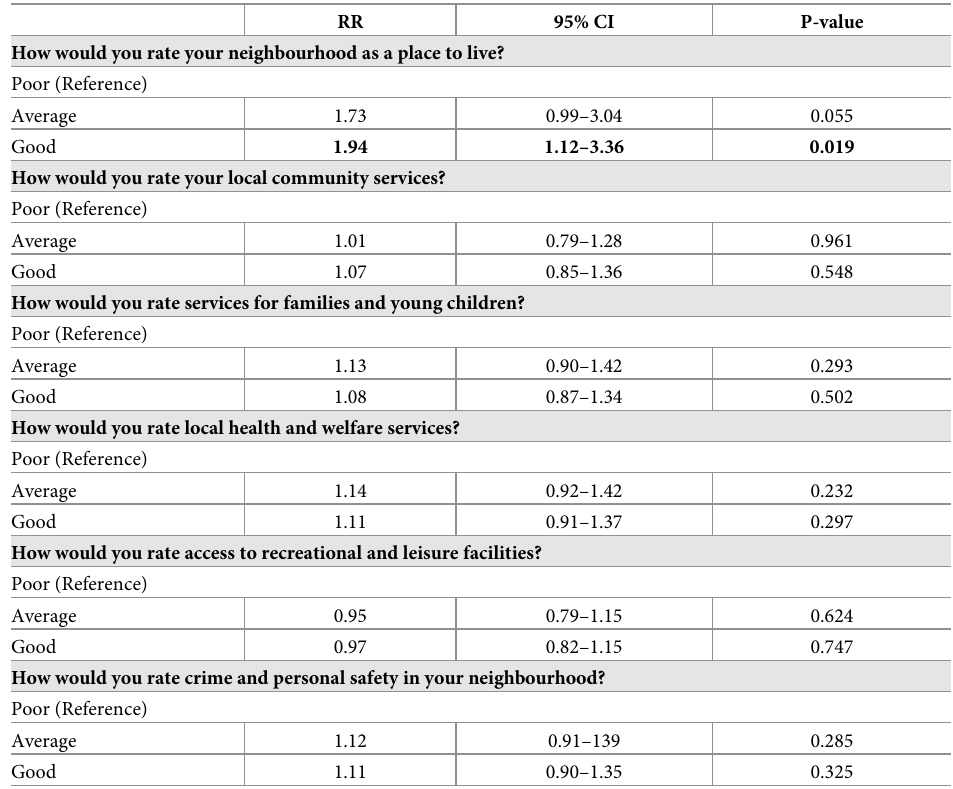
Table 3. Multivariate negative binomial regression results–neighbourhood